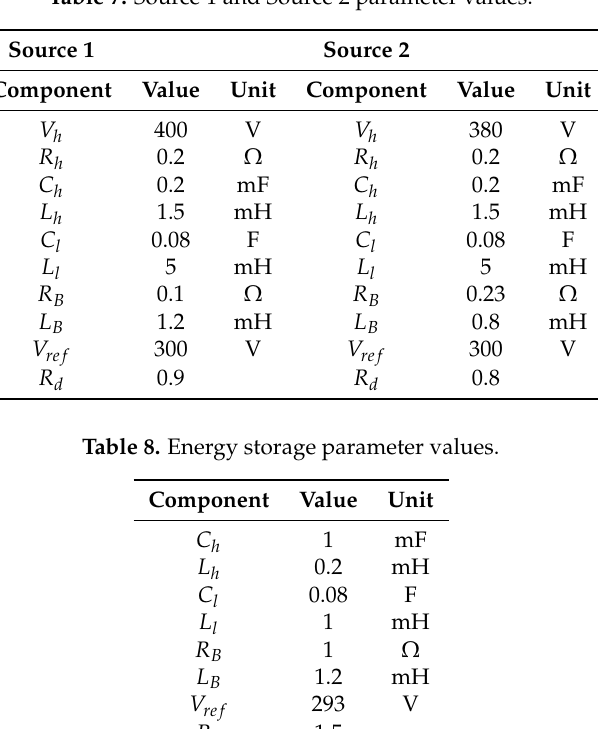
Table 7. Source 1 and Source 2 parameter values.